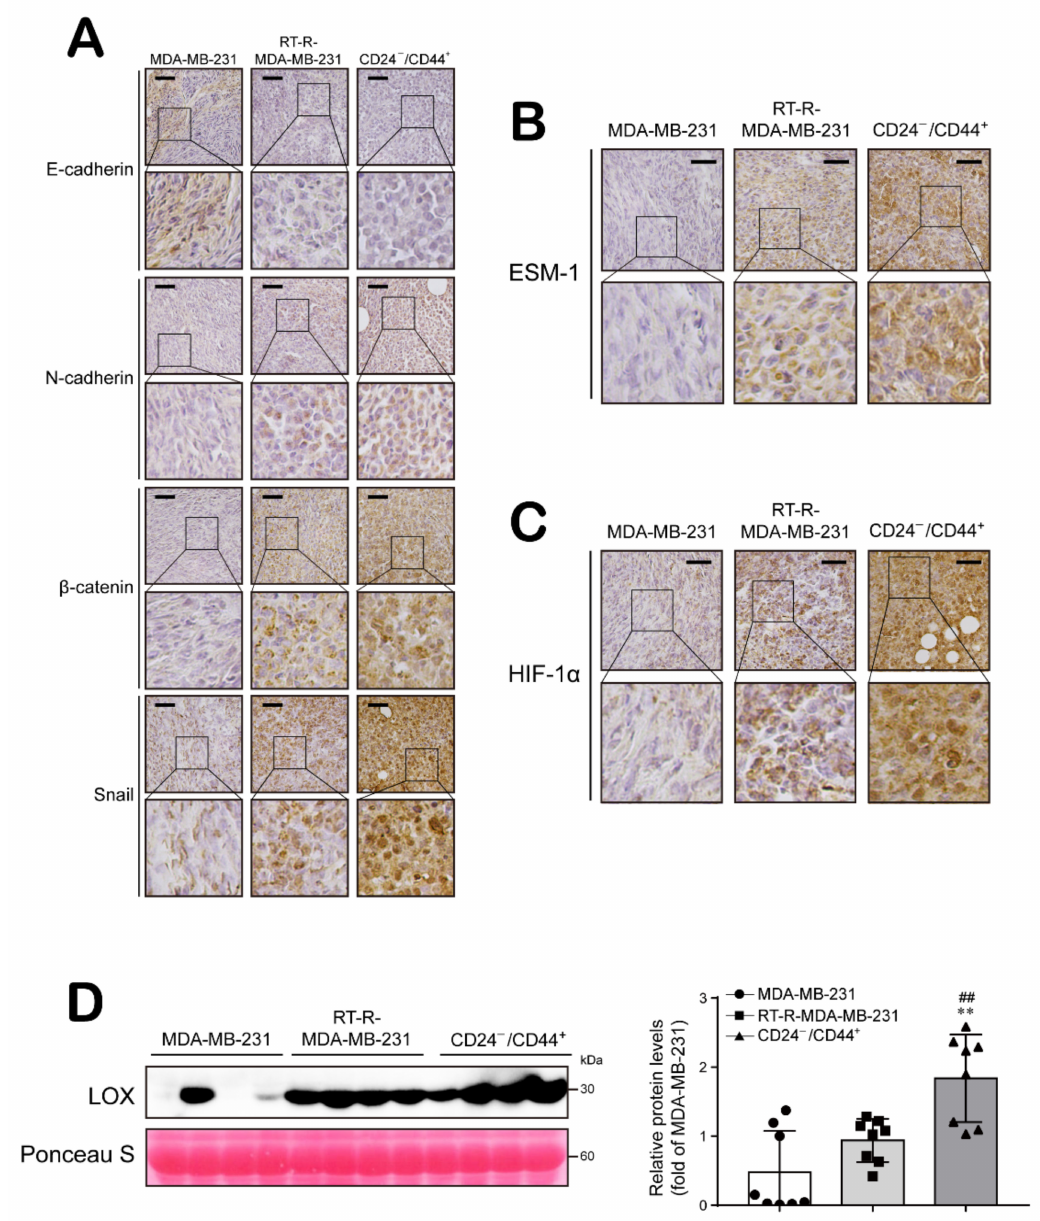
Figure 6. The expression of tumor progression- and metastasis-related molecules is highly upregulated in the tumor tissues of CD24 − /low /CD44 + BCSC-injected mice. ( A – C ) Tumor tissue sections were immunohistochemically stained with antibodies specific for the indicated proteins: The EMT-related proteins E-cadherin, N-cadherin, β -catenin, and Snail ( A ); the tumor progression-related protein ESM-1 ( B ); and the metastasis-related protein HIF-1 α ( C ). Then, the stained sections were counterstained with Mayer’s hematoxylin solution. Scale bar: 100 µ m. ( D ) The plasma LOX levels in blood samples were determined by Western blot analysis (n = 8 mice/group). ** p < 0.01 compared to the MDA-MB-231 cell-injected group; ## p < 0.01 compared to the RT-R-MDA-MB-231 cell-injected